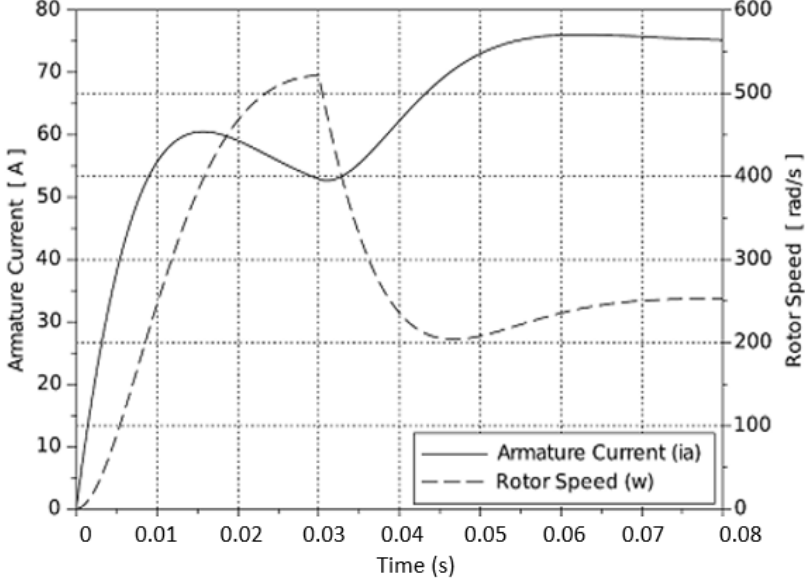
Figure 16. Load test results in Scilab for ω ( t ) , with a load torque = 5